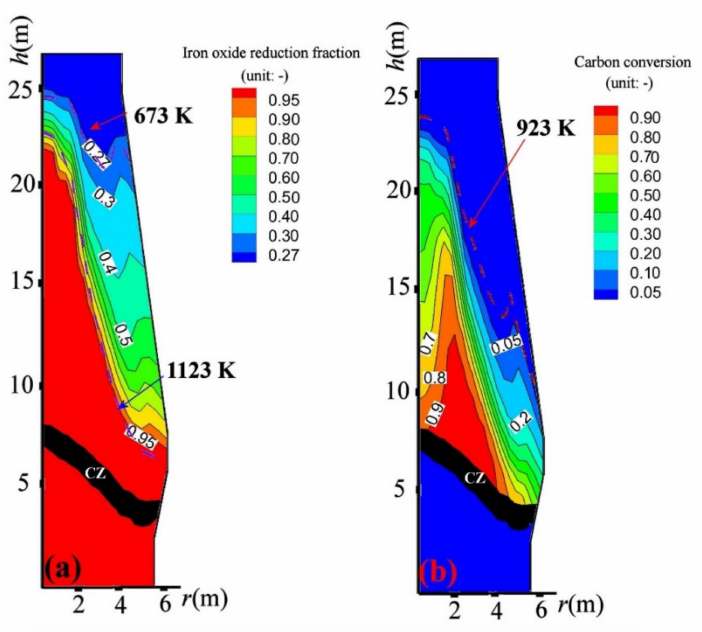
Figure 4. Reaction behavior of CCB in case B: ( a ). profile of CCB iron-oxide reduction fraction, ( b ). profile of CCB carbon